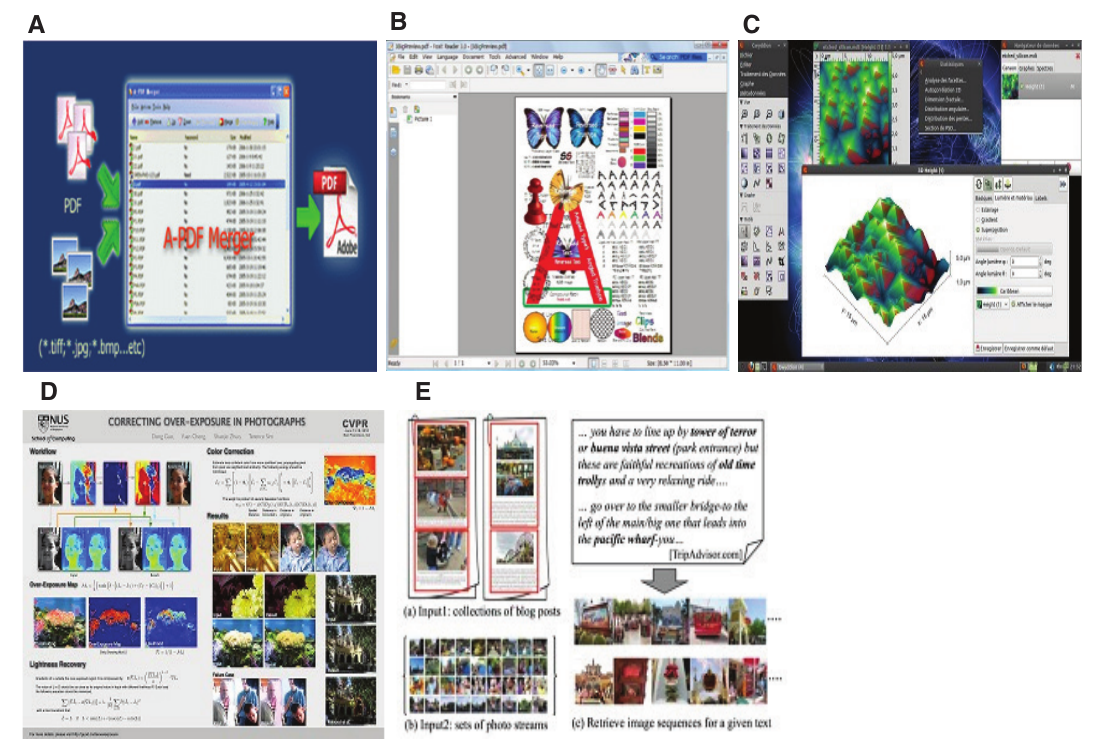
Figure 3: Test Images.